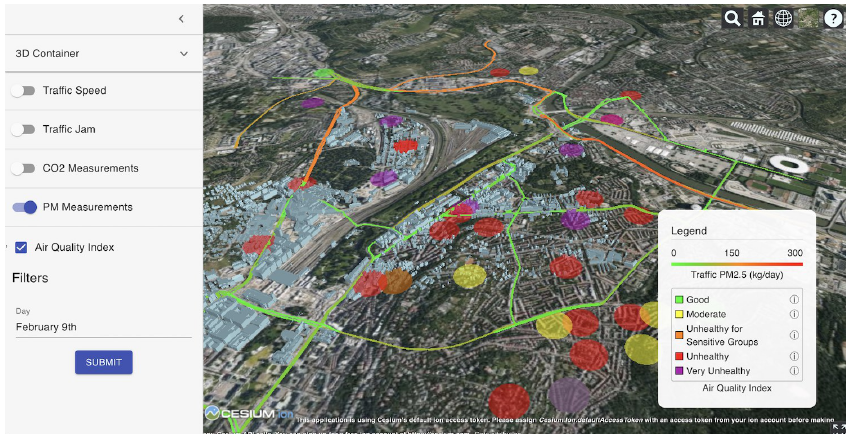
Figure 4. The proposed urban platform interface